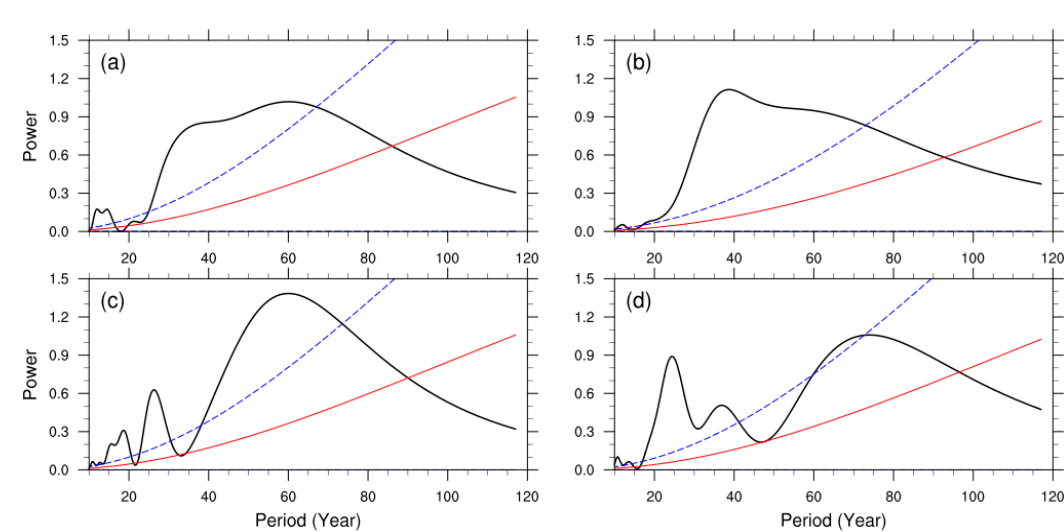
Figure 3. Spectrum of the first principle component of the decadal-to-multidecadal variability of land precipitation from GPCC in the northern hemisphere in ( a ) winter, ( b ) spring, ( c ) summer, and ( d ) autumn (black curves). The red solid curves are corresponding red noise spectrum, and the blue dashed curves are 5% confidence upper limit of red noise spectrum. The y-axis is power. The x-axis is period, unit: year.